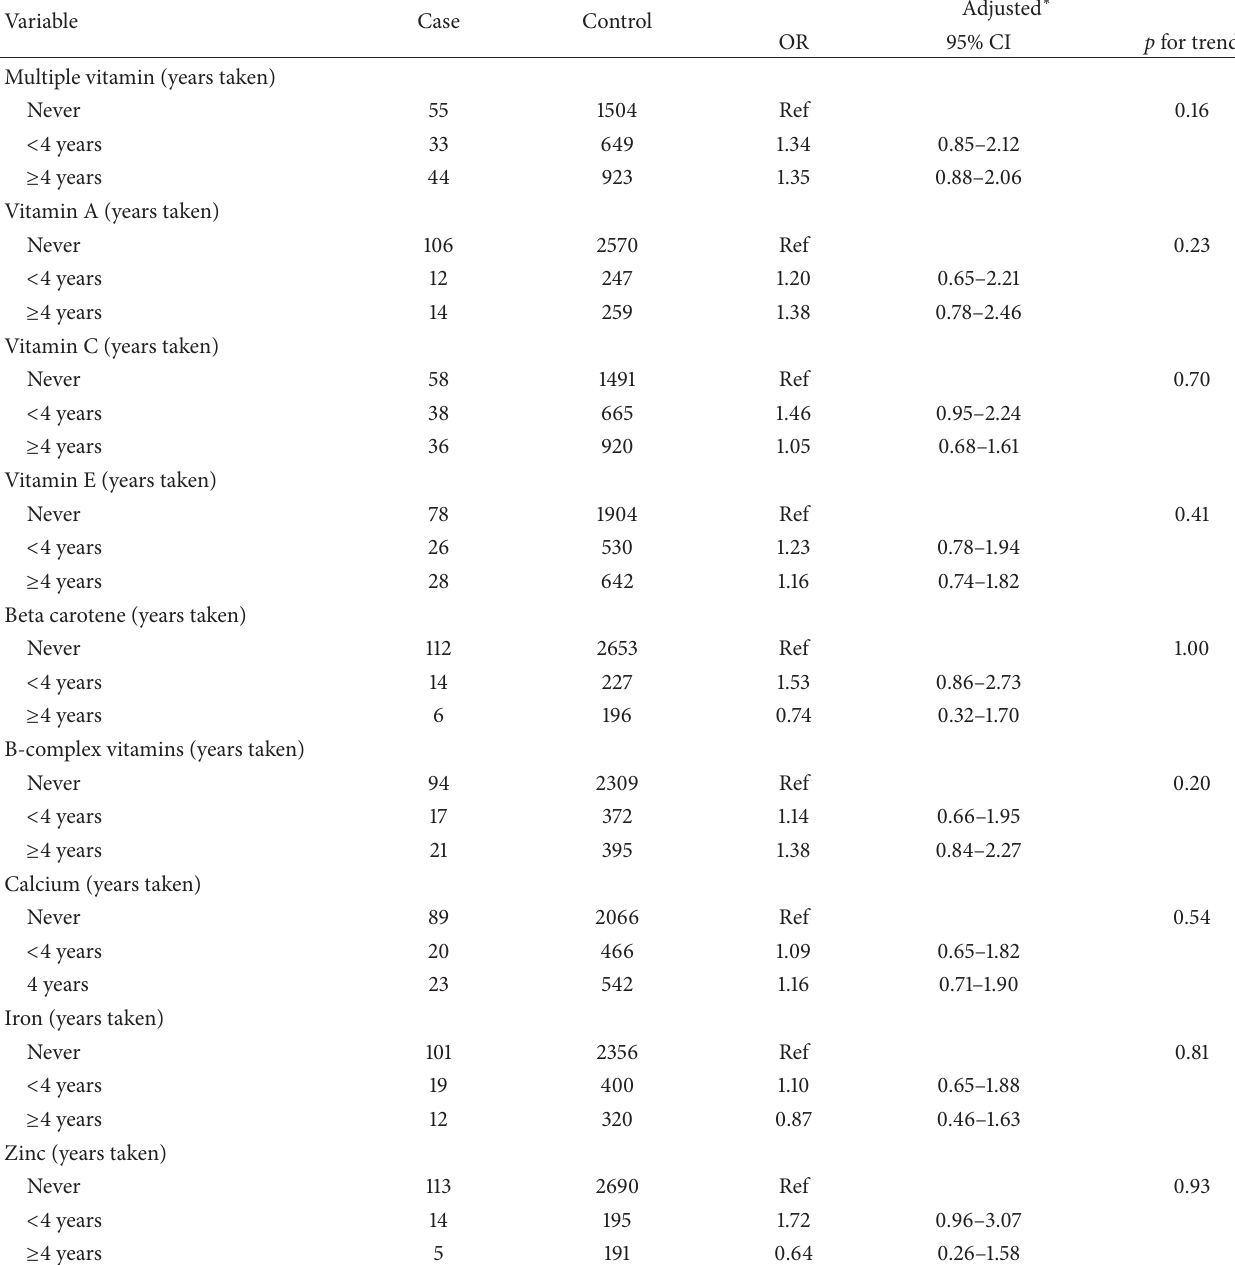
Table 5: Odds ratios of salivary gland cancer associated with some vitamin/mineral